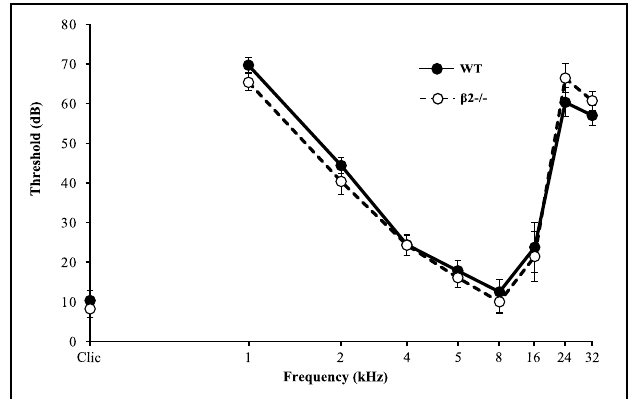
FIGURE 5 | Correlation between time in social contact and emission of USVs. Correlation between the number of calls and duration of contact in the SIT and 3Ch tasks. Datas are presented for WT and β 2 − / − mice. ∗∗ p = 0 . 005 for Spearman rank correlation test and NS: p > 0 . 05.